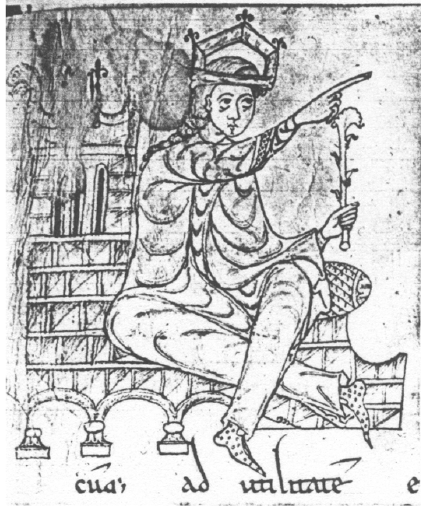
Figure 3. Carta de confirmación de privilegios , ACH. 2–16, Huesca, Archivo de la Catedral ©. Alphonse II. 1174. Published by Domínguez, J. Miniatura . In Ars Hispaniae , Plus Ultra: Madrid, Spain, 1958, Figure 6.